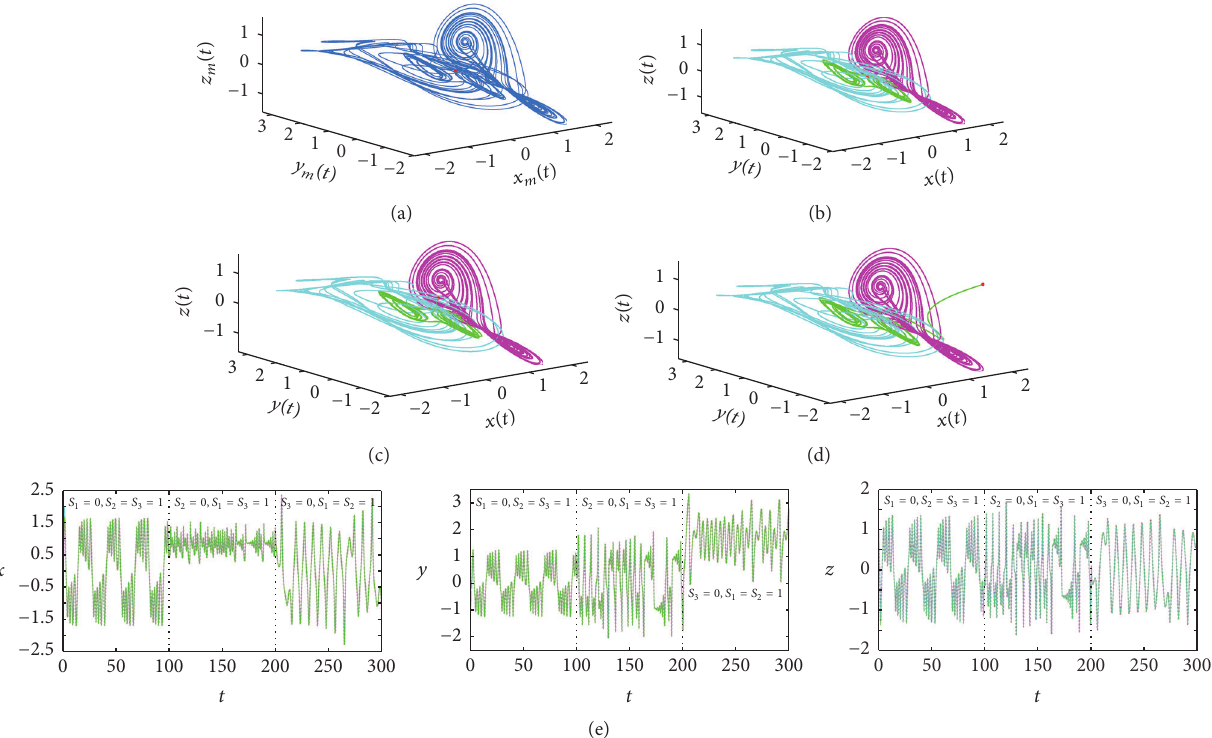
Figure 5: Attractors of (a) the master system when switching from CNN-3 cells to Liu then to Financial system as a master each for one-third of the simulation time and the resulting new (b) CNN-3 cells, (c) Liu, (d) Financial systems, and (e) time series successfully synchronized.